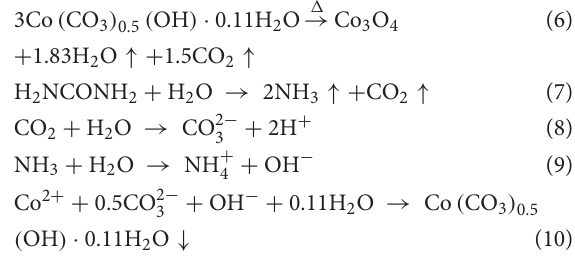
Frontiers in Chemistry |